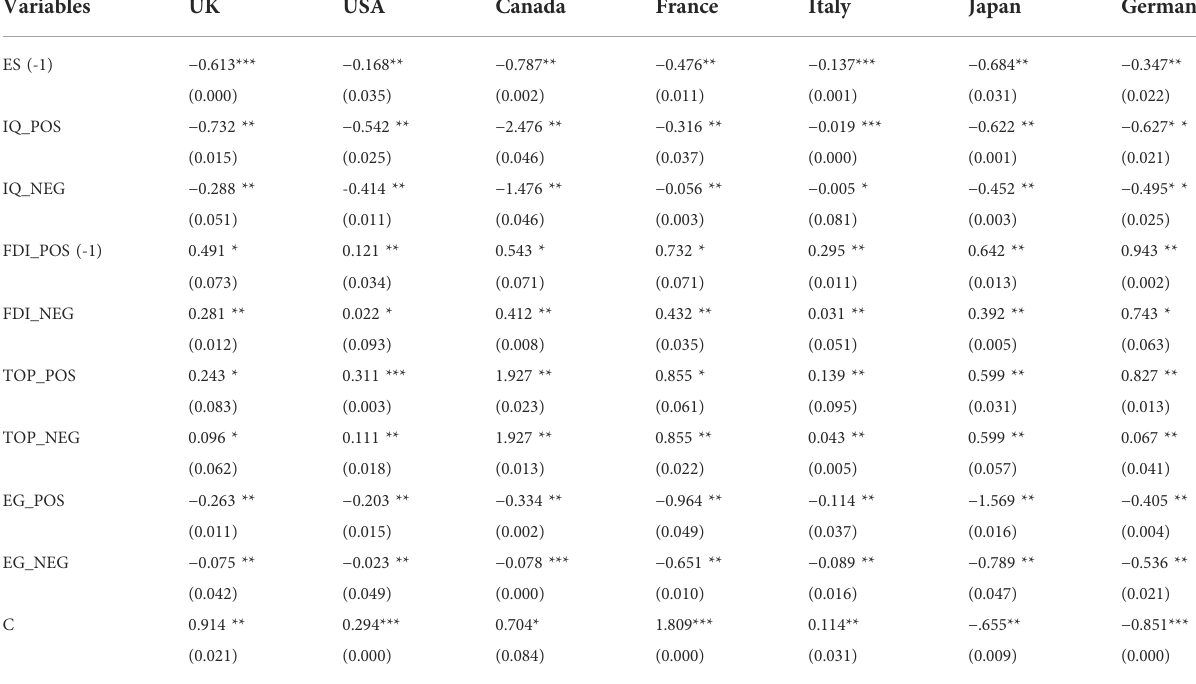
TABLE 5 Dynamic asymmetric ARDL